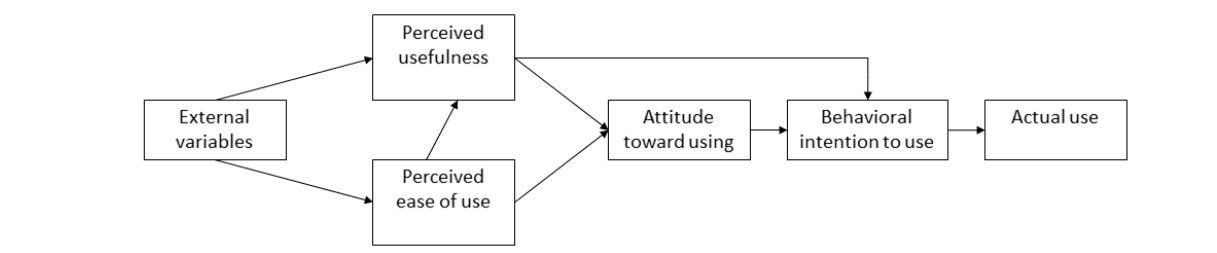
Figure 2. Technology acceptance